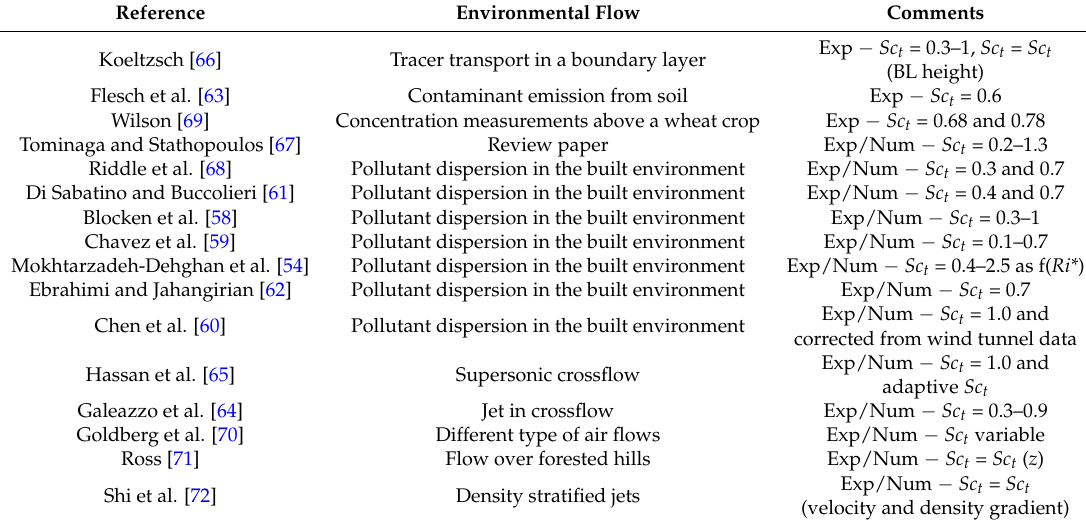
Table 3. Values of the turbulent Schmidt number from atmospheric systems